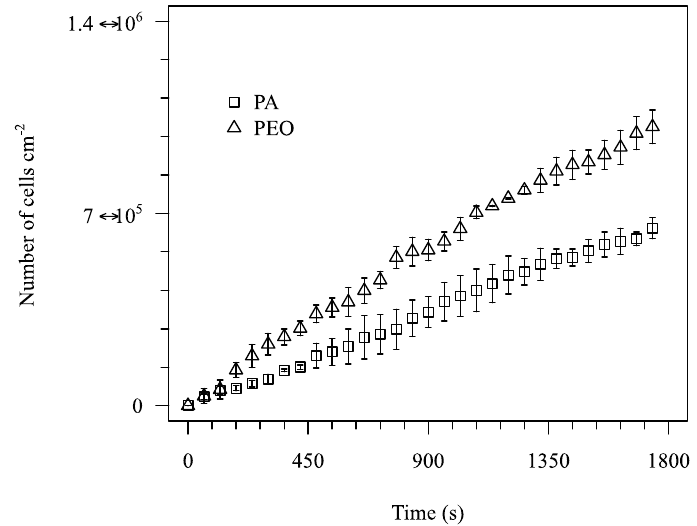
Figure 7. Number of adhered cells per cm 2 for PA and PEO for nominal wall shear stress of 0.01 Pa.